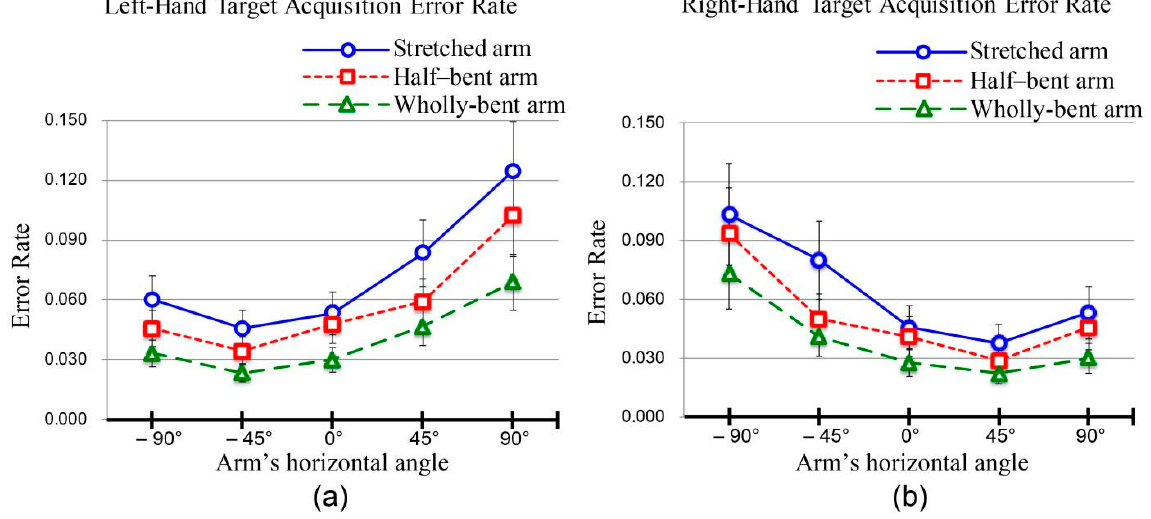
Figure 5. Target acquisition error rates at different bending degrees of the arm: ( a ) left-hand interaction result; ( b ) right-hand interaction result.